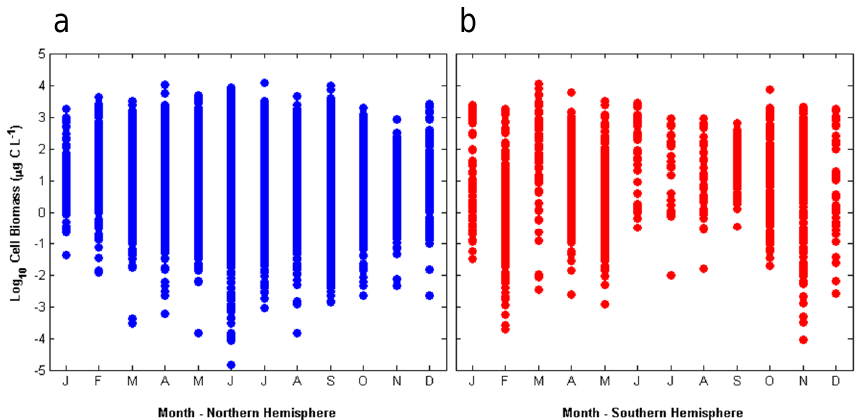
Figure 7. Seasonal distribution of log-normalized diatom biomass data (log 10 µ gCl − 1 ) for the Northern (a) and Southern (b)